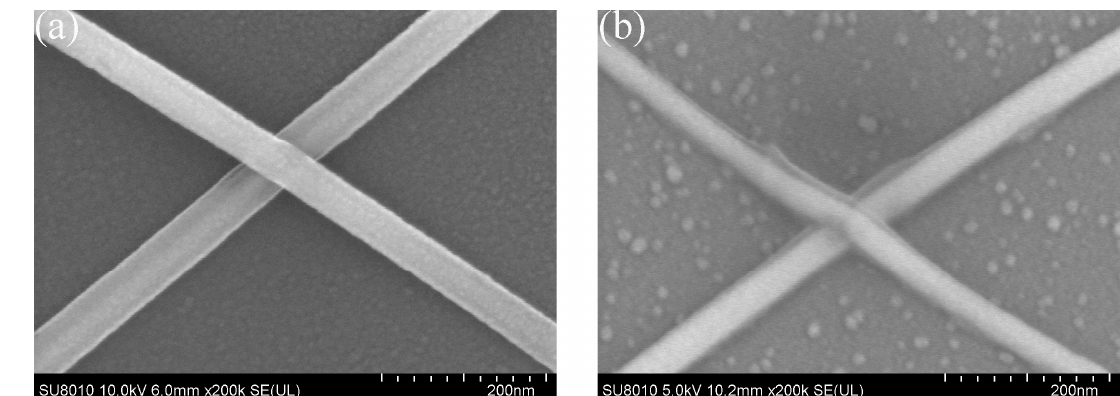
Figure 3. Schematic diagram of capillary force.